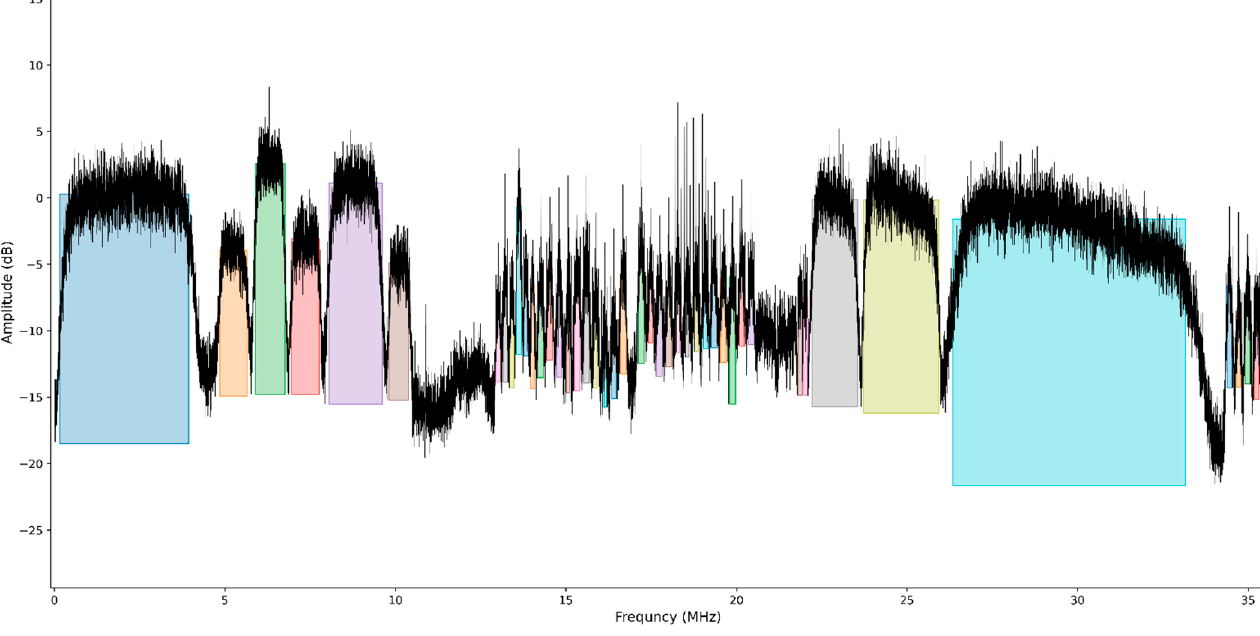
Figure A5. Example5 of the actual satellite broadband power spectrum set.